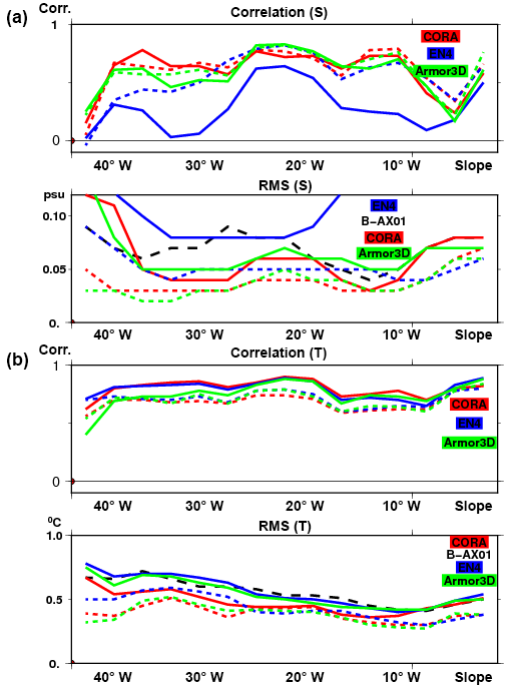
Figure B1. Comparison in 1993–2015 of S and T from B-AX01 with EN4 (blue) and CORA (red) gridded data (surface, full lines; 0–500m vertically integrated, dashed lines). Correlation coeffi- cients are plotted, as well as the standard deviations in the differ- ent products (rms( S ) and rms( T ) plots; the dashed black line is for B-AX01 data). (a) is for S , and (b) is for T